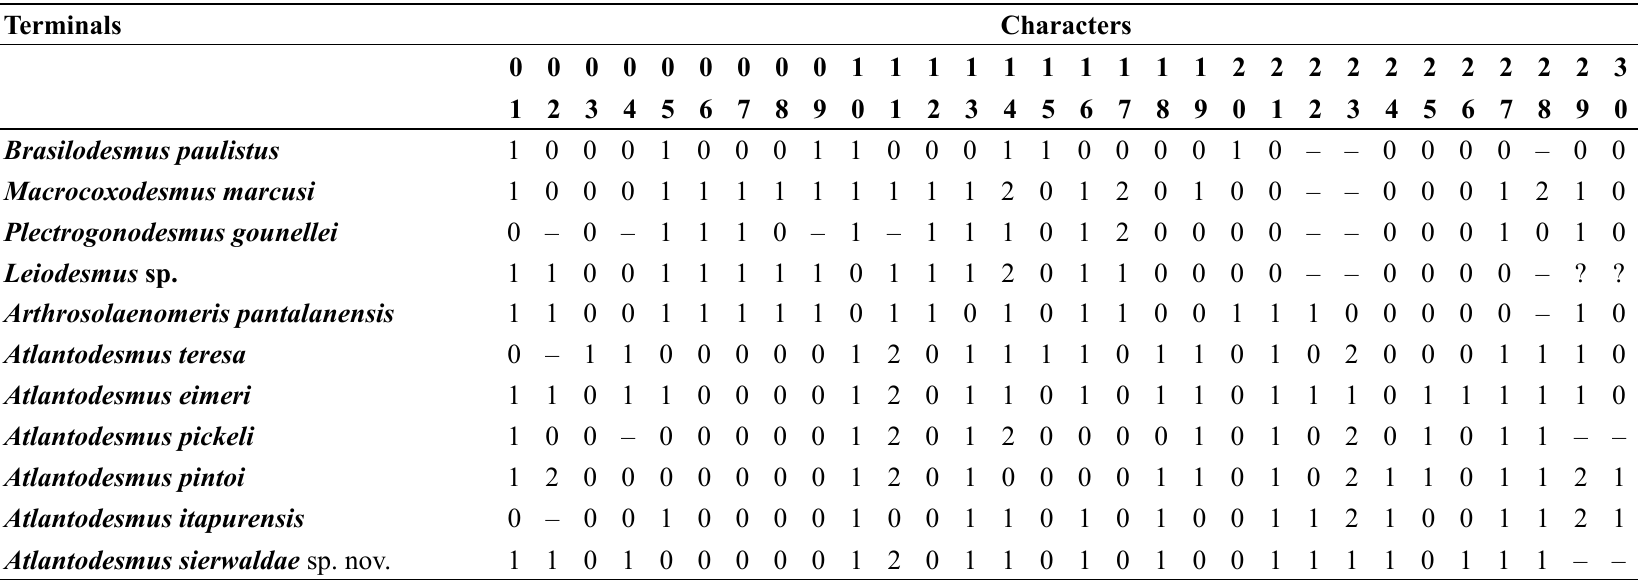
Table 1. Morphological matrix for the cladistic analysis of the genus Atlantodesmus Hoffman, 2000. – = inapplicable characters; ? = unobserved characters. All characters were treated as